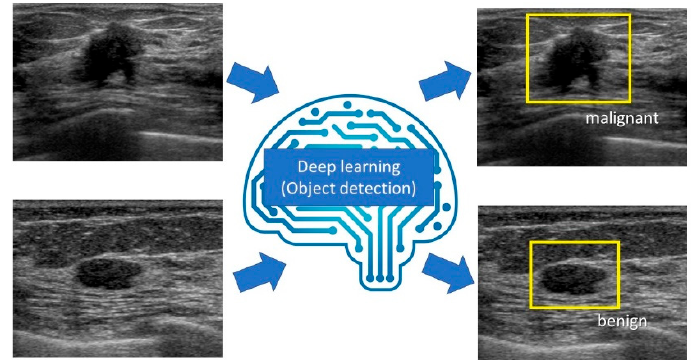
Figure 5. The diagram of object detection for breast ultrasound.